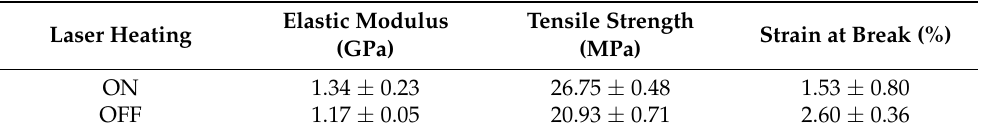
Table 8. Effect of laser heating during printing on the tensile properties of PLA + 2% graphite specimens. Elastic Modulus Tensile Strength Strain at Break (%) Laser Heating (GPa) (MPa) ON